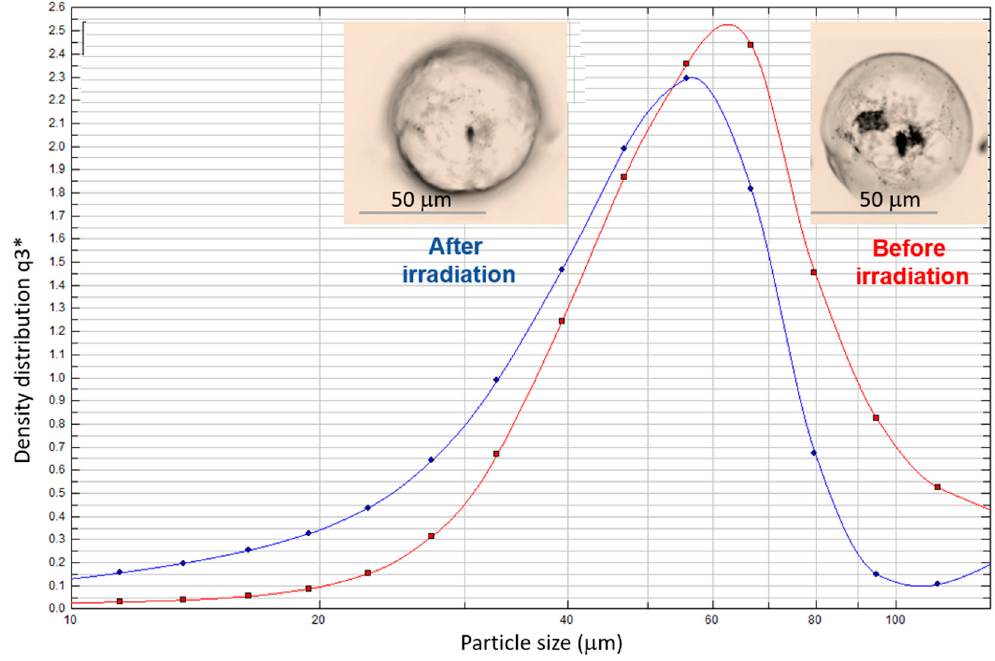
Figure 4. Optical microscopy of single MC4 microcapsule surface morphology changes and laser diffraction particle size analysis of MC4 microcapsules before and after 12 min of irradiation with visible light.